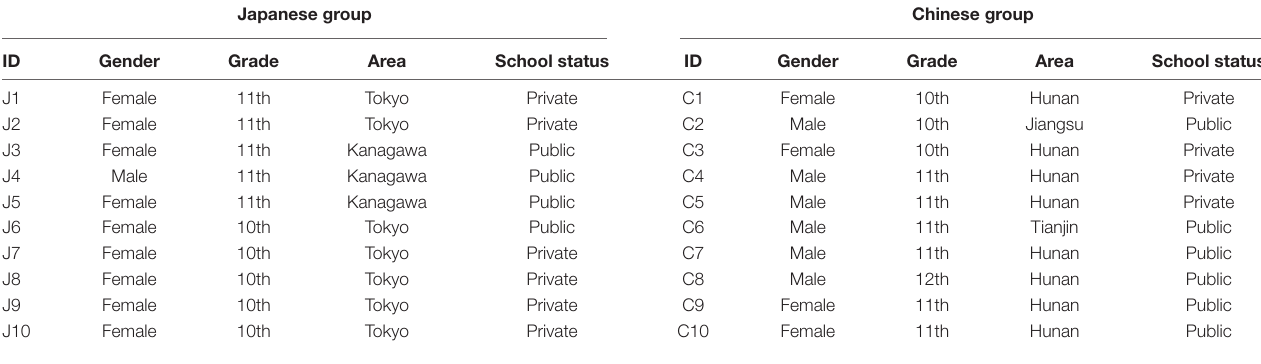
TABLE 1 | Participants’ gender, grade, and school